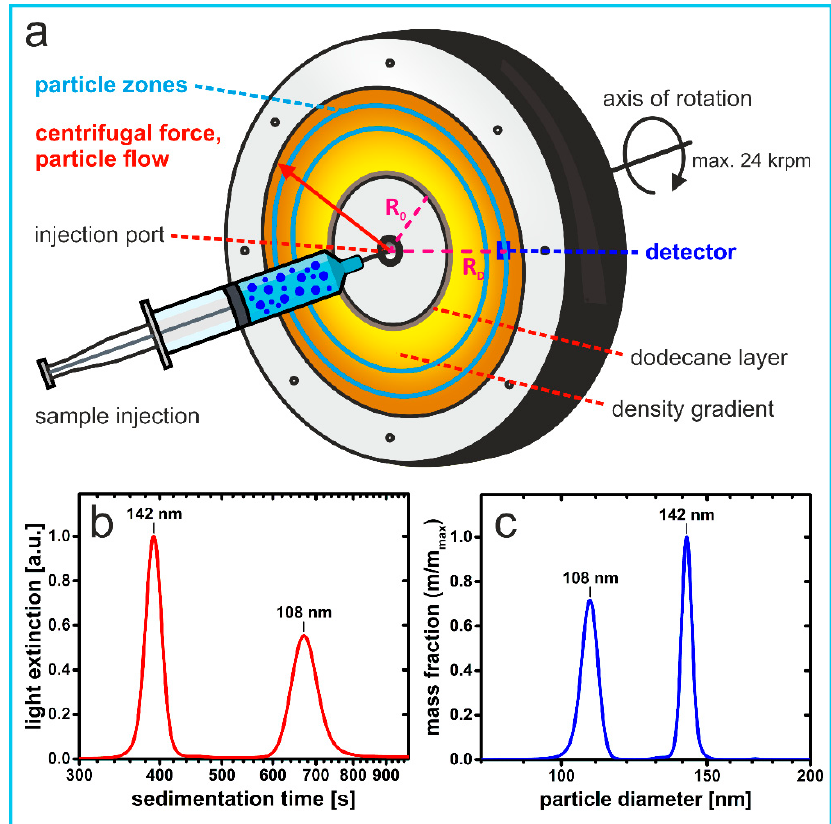
Figure 1. Differential centrifugal sedimentation (DCS) using a disk centrifuge: ( a ) A density gradient capped with dodecane is built within a rotating hollow, optically transparent disk. The sample is placed on top of the gradient via a central injection port. Different particle populations migrate as discrete zones at rates specified by their respective sedimentation coefficients. Attenuation of laser light is recorded continuously to quantify the scattering by particles arriving at a fixed detector position as a function of the sedimentation time. ( b ) Raw data of a DCS run demonstrating the high-resolving power of DCS: As an example, the analysis of a bimodal nanoparticle mixture differing by a few nanometers is shown. The latter contains spherical polystyrene latex particles with number-averaged diameters of 142 nm and 108 nm. It should be noted that the first particle population is identical to the elementary units of the clusters studied in this work, whereas the smaller particles were obtained by increasing the emulsifier concentration during particle synthesis. ( c ) For spherical particles, a particle size distribution is obtained after (i) conversion of the light extinction into particle concentrations using Mie theory, and (ii) recalculation of sedimentation times according to Equation (4).